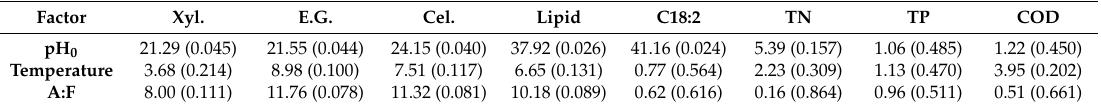
Table 5. Factorial analysis on the parametric factors involved in the Taguchi analysis. The numbers account for the F statistics calculated from the Analysis of Variance (ANOVA) of the model (Supplementary Materials) and the number in parenthesis account for the significance of the parameter measured as p -value. Factor Xyl. E.G. Cel. Lipid